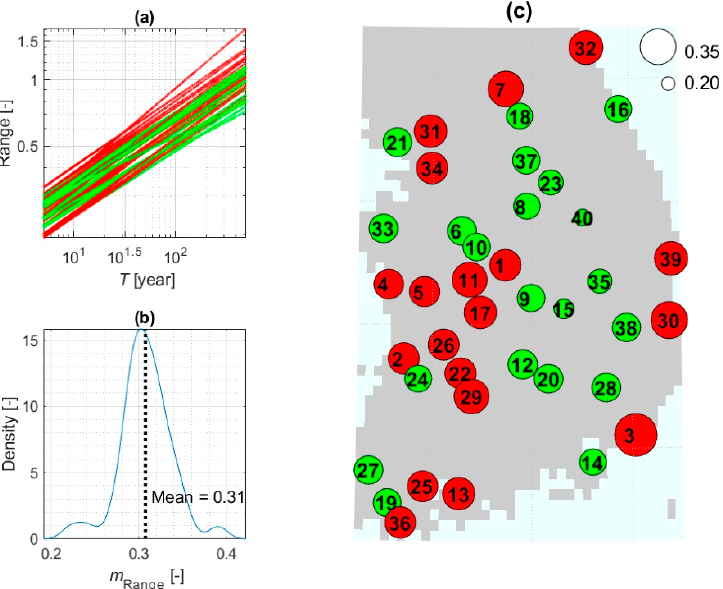
Figure 9. Varying degree of increase of the uncertainty range (Range), i.e., the difference between 5th and 95th percentiles of the normRI ensemble over return periods ( T ) for 1-h duration for future END period of RCP 8.5. Subplot ( a ) illustrates the uncertainty range over return periods for 40 locations. Subplot ( b ) represents a kernel distribution of the slopes of Range ( m Range ) for 40 lines in subplot ( a ). The red (green) lines in subplot ( a ) refer to locations with their slopes greater (smaller) than mean value—the black dashed line in subplot ( b ). Subplot ( c ) illustrates the spatial distribution of the slope, the colored circles correspond to the colored lines in subplot ( a ). The number near white circles is the legend to show the relative magnitude of slopes.